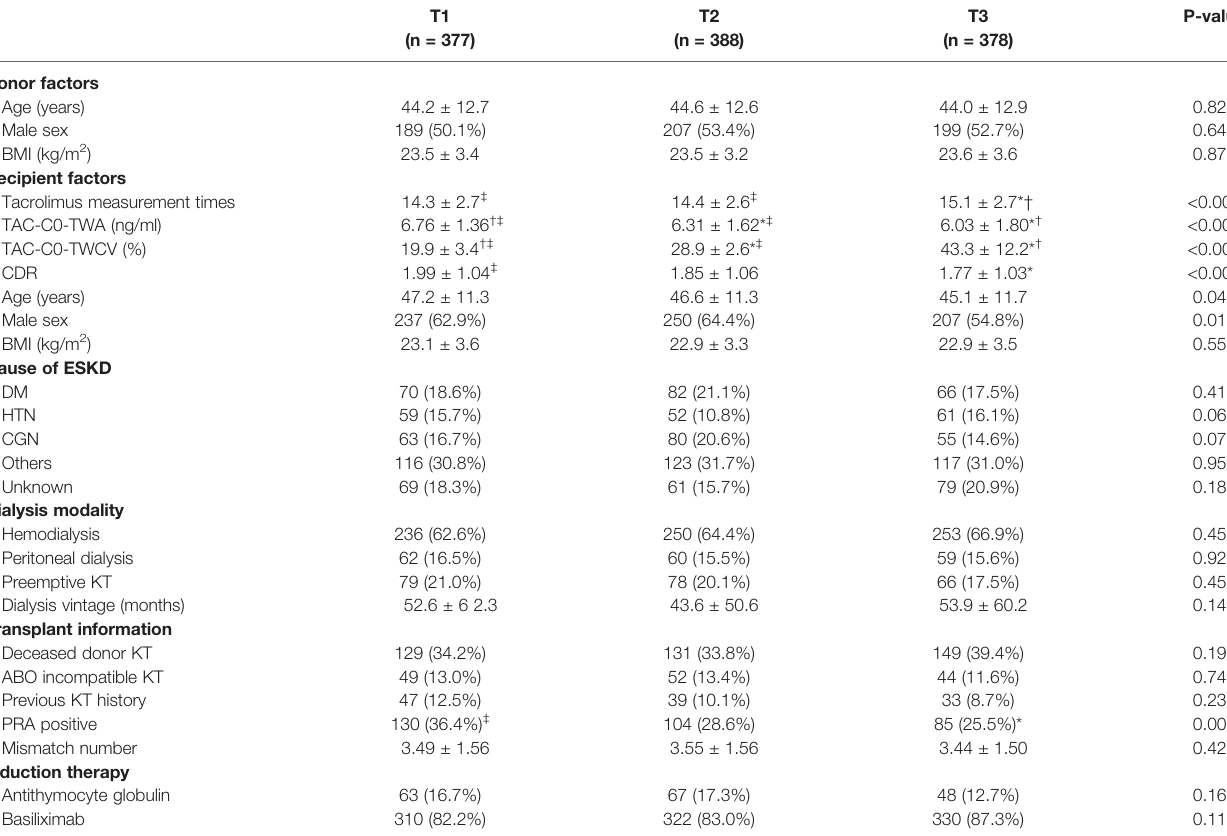
TABLE 1 | Baseline characteristics according to TAC-C0-TWCV tertiles up to post-transplant fi rst year.